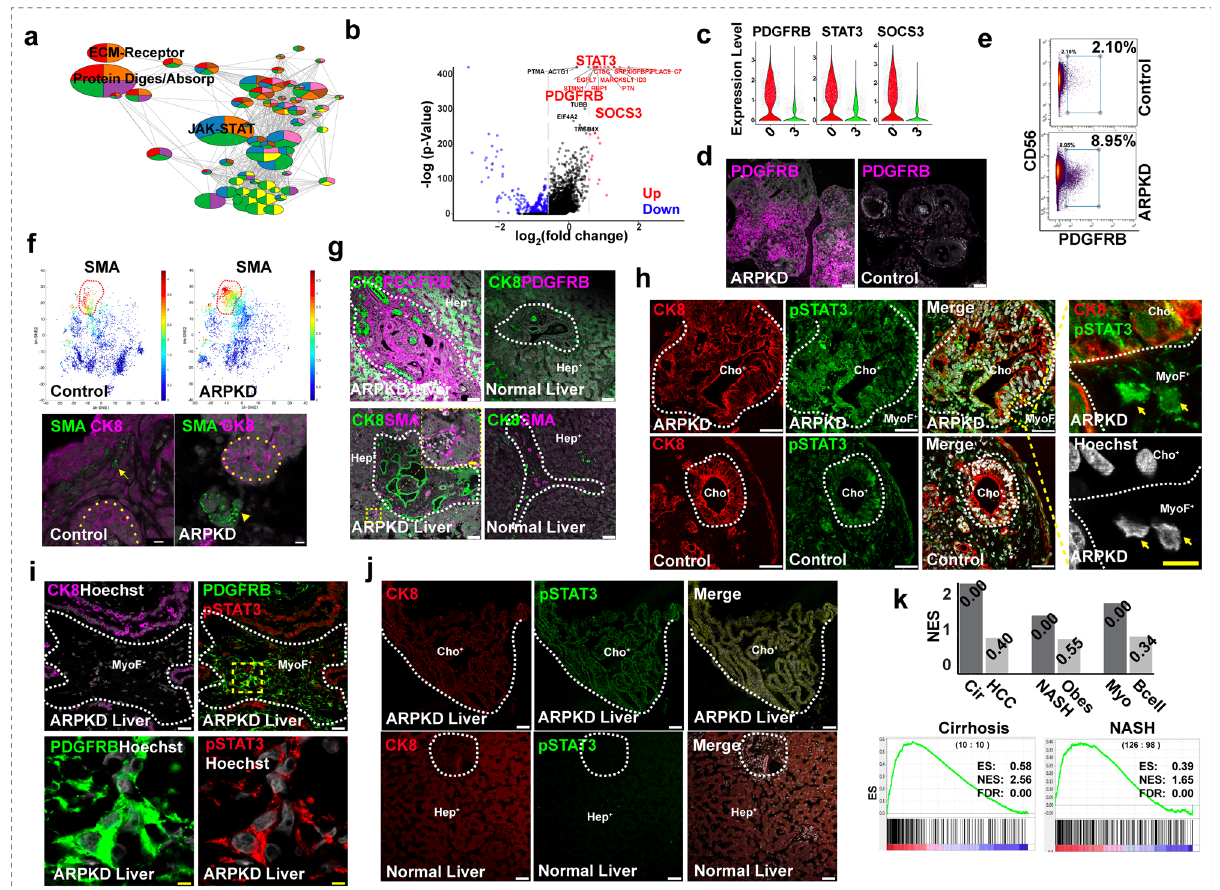
Fig. 5 ARPKD HOs have an expanded population of myo fi broblasts that resemble those in fi brotic human liver tissue. a KEGG pathway enrichment analysis identi fi es 3 gene networks whose expression is most increased in cluster 0 cells: protein digestion and adsorption, JAK-STAT signaling, and extracellular matrix (ECM)-receptor interactions. b A volcano plot showing the differentially expressed genes (fold change > 1.5, adjust p -value < 0.05) when the transcriptomes of cluster 0 and cluster 3 are compared. The 20 genes whose mRNAs exhibit the highest level of differential expression are highlighted, which include STAT3, PDGFRB, and SOCS3. The gray dashed line indicates the 1.5-fold cutoff for a differentially expressed gene. A red (or blue) color indicates that a gene is up (or down) regulated in cluster 0 (vs. cluster 3); a black color indicates that the expression level was not signi fi cantly different. The differentially expressed genes among the groups were determined using the Wald test in DESeq2. c Violin plots showing three genes ( PDGFRB, STAT3 , SOCS3 ) whose mRNAs were markedly increased in cluster 0 cells relative to cluster 3. d Day 21 control and ARPKD organoids were immunostained with an anti-PDGFRB antibody. PDGFRB is highly expressed in ARPKD, but not in control, HOs. Scale bar, 50 μ m. e A scatter plot of CyToF data performed with anti-PDGRF Β and anti-CD56 antibodies shows that ARPKD organoids have a markedly increased amount of PDGFRB + cells (9.0%) relative to control organoids (2.1%). f bhSNE maps (upper) generated from CyToF data indicate that ARPKD HOs have an increased amount of SMA + cells. (Lower) Representative images of HOs immunostained with anti-smooth muscle actin (SMA) and anti-CK8 antibodies. The yellow dotted lines indicate ductal structures. While only a few SMA + cells were present at a limited number of sites within control organoids (indicated by an arrow); large clusters of SMA + cells were present within ARPKD organoids (indicated by arrowhead) and were located near ductal structures. Scale bar, 10 μ m. g Normal and ARPKD liver tissue was immunostained with antibodies to PDGFRB, CK8, and SMA. PDGFRB expression was much higher in ARPKD than in control liver tissue. Also, SMA + cells were only located within perivascular regions of normal liver tissue; but they in fi ltrate the parenchyma of ARPKD liver tissue (as shown in the inset). The white dashed line separates epithelial and mesenchymal areas. Scale bar, 50 μ m. h ARPKD and Control HOs were immunostained with anti-CK8 and anti-phospo-STAT3 (Tyr705) antibodies. Phospho-STAT3 was extensively expressed in bile duct and mesenchymal cells in ARPKD HOs. The right panels are enlargements of the boxed yellow area in the ARPKD organoid; the arrows indicate mesenchymal cells with Phospho-STAT3 within the nucleus. Scale bar, 5 μ m. i , j ARPKD and normal liver tissues were immunostained with antibodies to CK8, Phospho-Stat3, and CK8, and were counterstained with Hoechst. i Low (top) and high (bottom) power views of ARPKD liver tissue immunostained with antibodies to CK8, PDGFRB, and Phospho-STAT3. A myo fi broblast area with is within the dotted line. A high-power view of the yellow boxed area shows phospho-STAT3 is co-localized within PDGFRB + myo fi broblasts. Scale bar, 5 μ m. j Phospho-STAT3 is extensively expressed in an enlarged bile duct within ARPKD liver tissue, but its level of expression is much weaker in normal bile ducts. k The bar graph shows the GSEA results (normalized enrichment score (NES)) obtained from each analysis; and the false discovery rate (FDR) for each comparison is shown at the top of each bar. The myo fi broblast gene expression signature was very strongly associated with cirrhotic and NASH liver tissue, but this signature was not induced by obesity alone or by the presence of a HCC. GSEA was also performed by comparing the cluster 0 cell transcriptome with overlapping genes present in the expression signatures de fi ned from the scRNA- Seq analysis of myo fi broblasts and B cells present in cirrhotic human livers 39 . Bottom: GSEA results for the correlation of the ARPKD myo fi broblast gene expression signature with that in liver tissues obtained from: 10 normal and 10 cirrhotic subjects (Cirrhosis); 98 normal and 126 NASH subjects